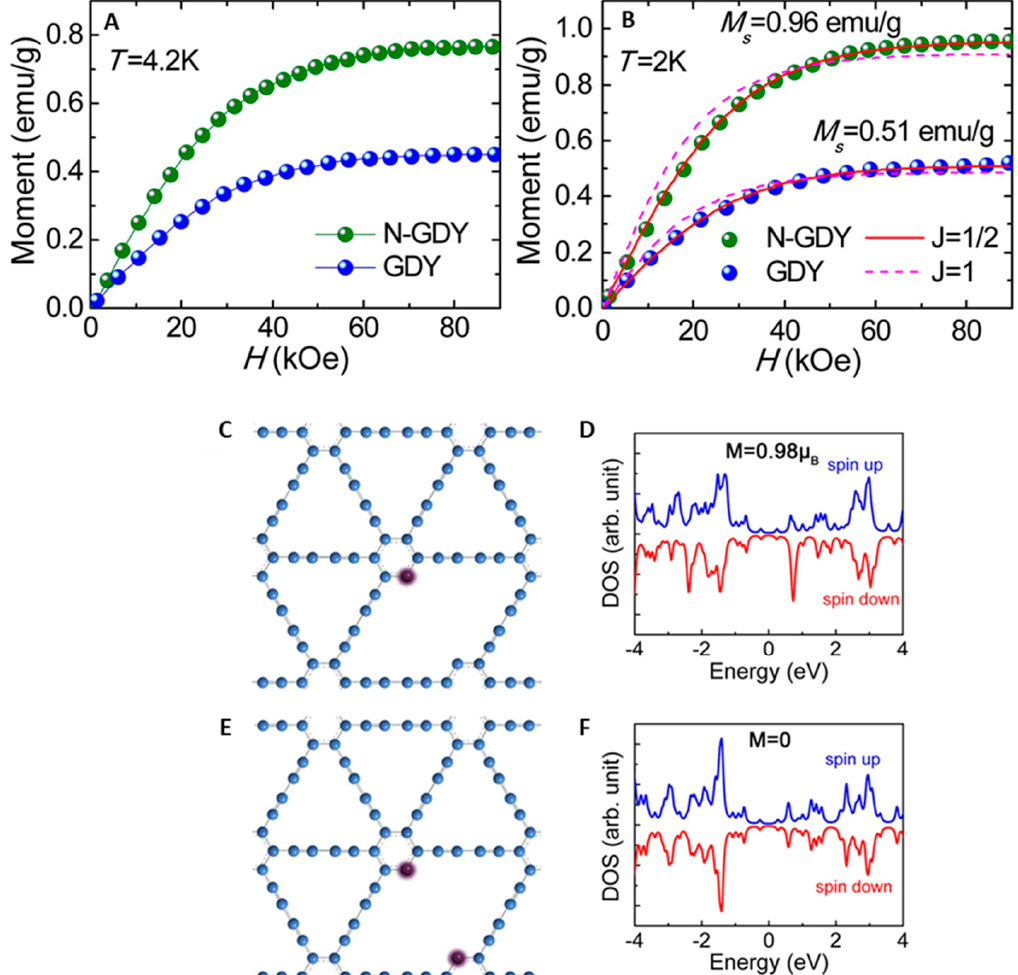
Figure 20. M–H curves obtained at 4.2 K ( A ) and 2 K ( B ) for GDY and N-GDY. Obtained results were fitted to the Brillouin function with J = 1/2 (solid line) and J = 1 (dashed line) ( B ). Spin-resolved DOS of N-GDY films with nitrogen atoms deposited on the benzene ring in GDY. The upper panel ( C , D ) shows the paramagnetic S = ½ system, while the bottom one the antiferromagnetic one ( E , F ). Reproduced with permission [174]. Copyright 2017, Springer Nature.